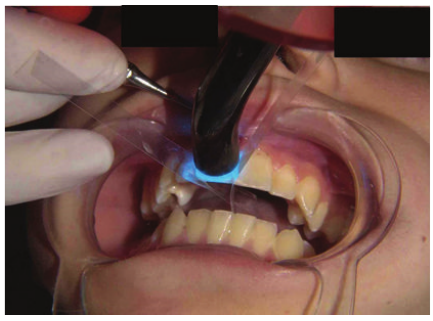
Figure 7: Photopolymerization of the flow resin.